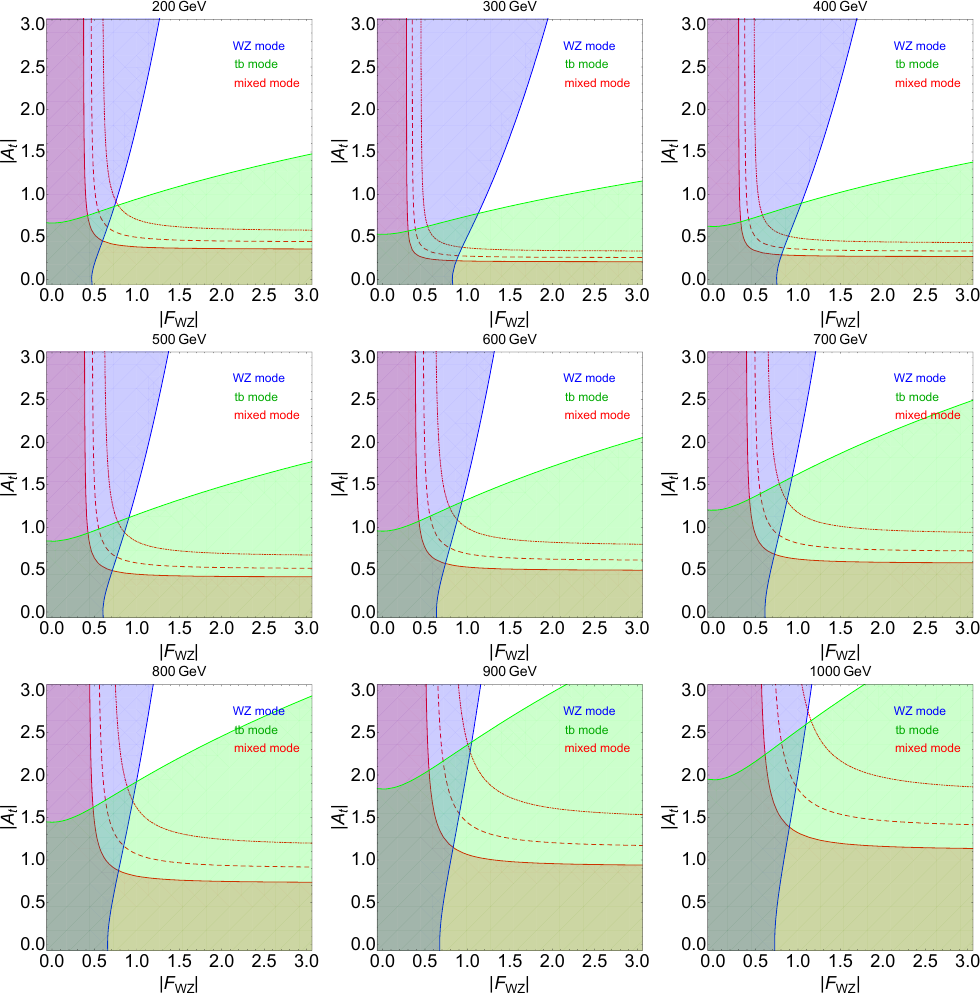
= 200{1000 GeV with the H (cid:6)